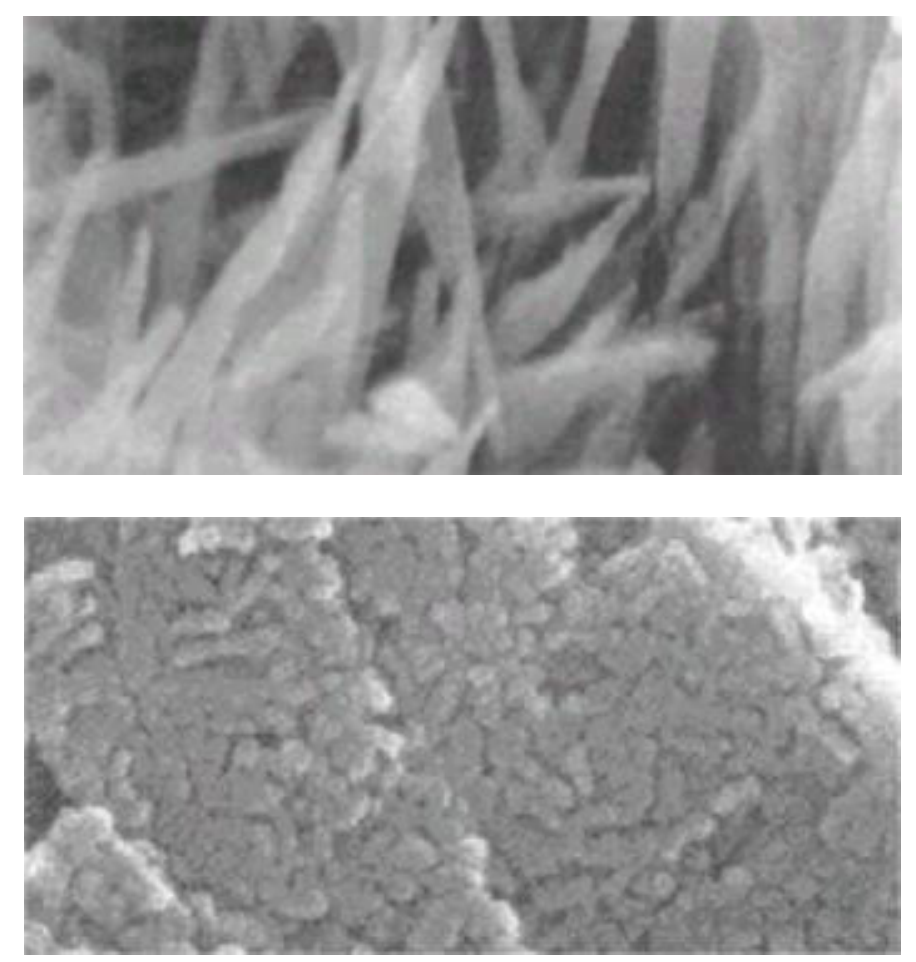
Figure 7. Typical scanning electron microscopic image of apatite cement consisting of TTCP and DCPA. Upper image = surface; lower image = interior